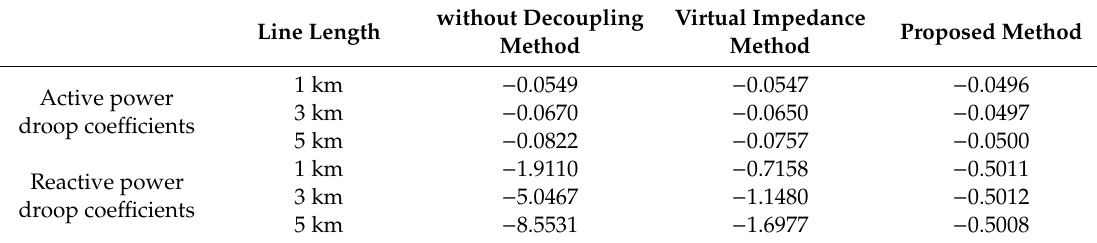
Table 4. Terminal droop coe ffi cient of connecting line with di ff erent lengths.